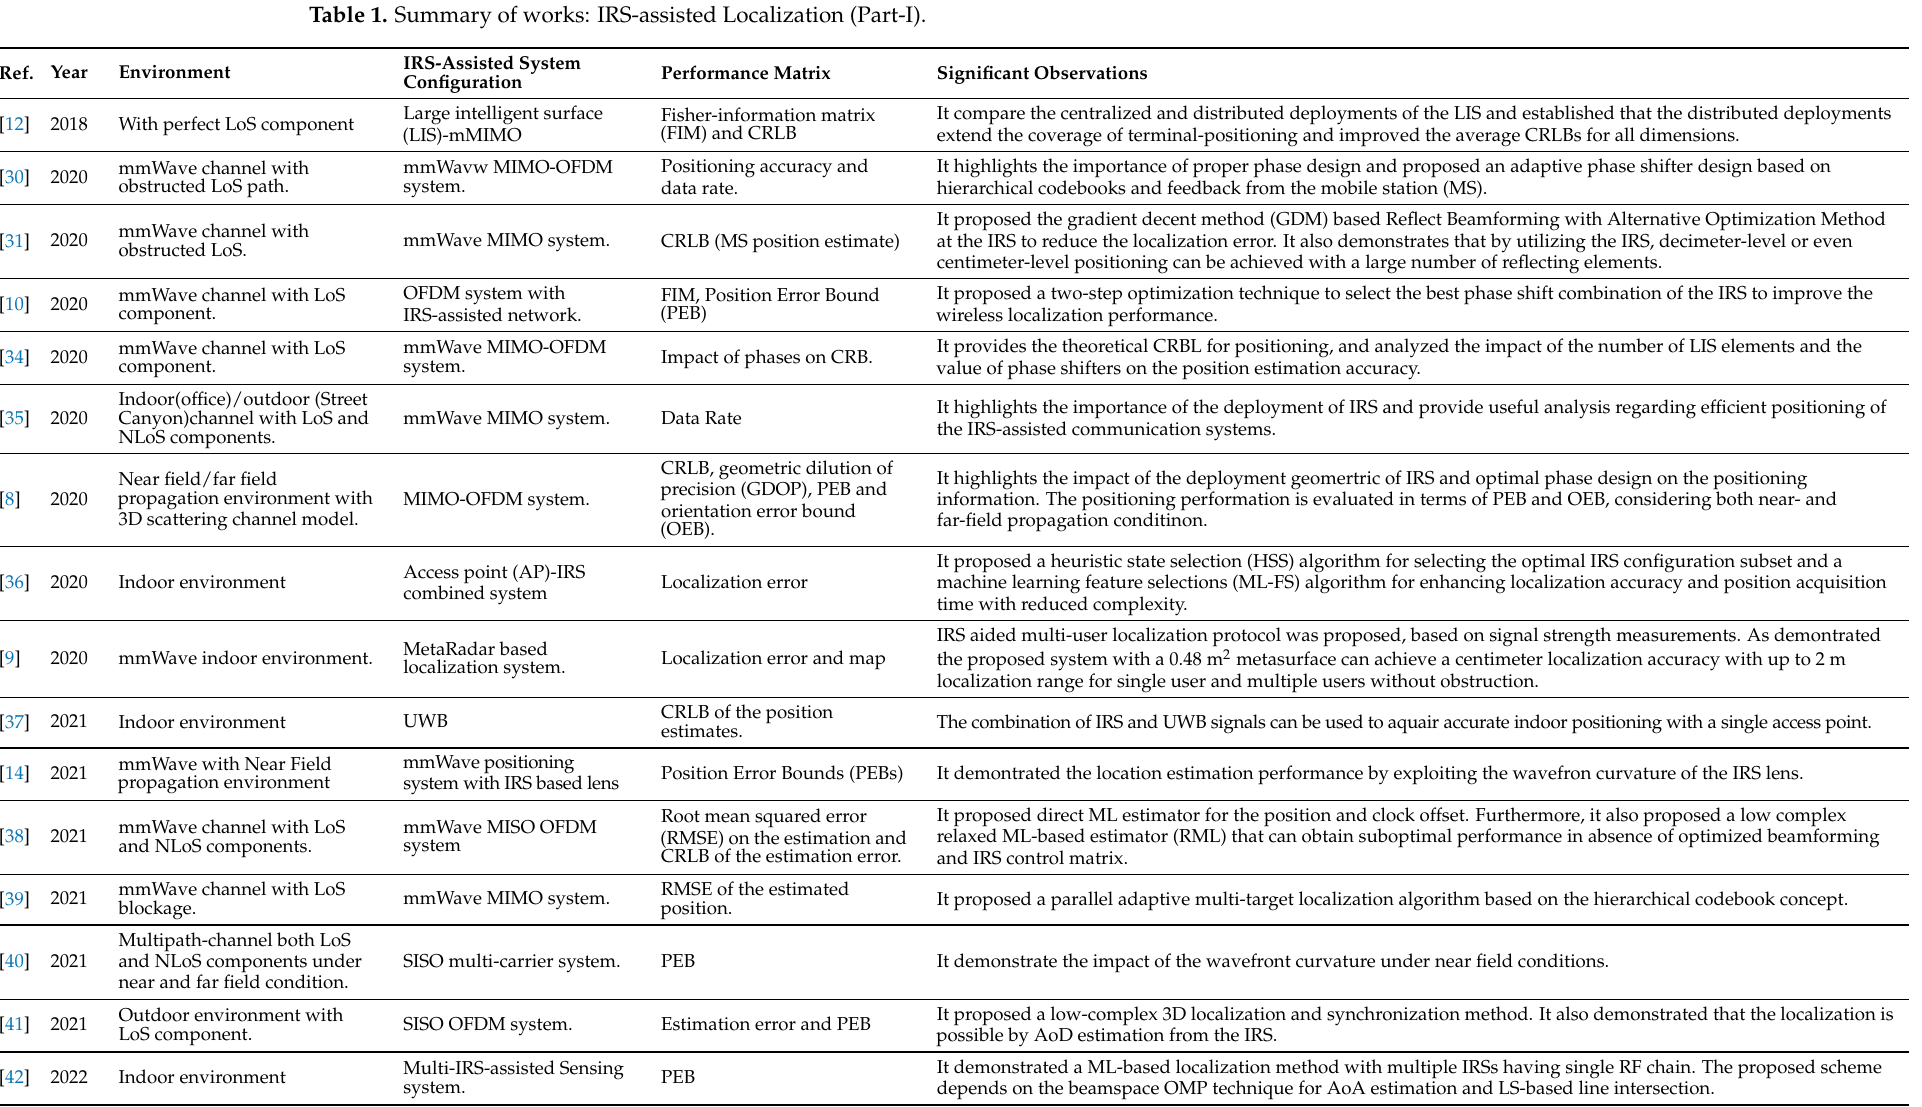
Table 1. Summary of works: IRS-assisted Localization